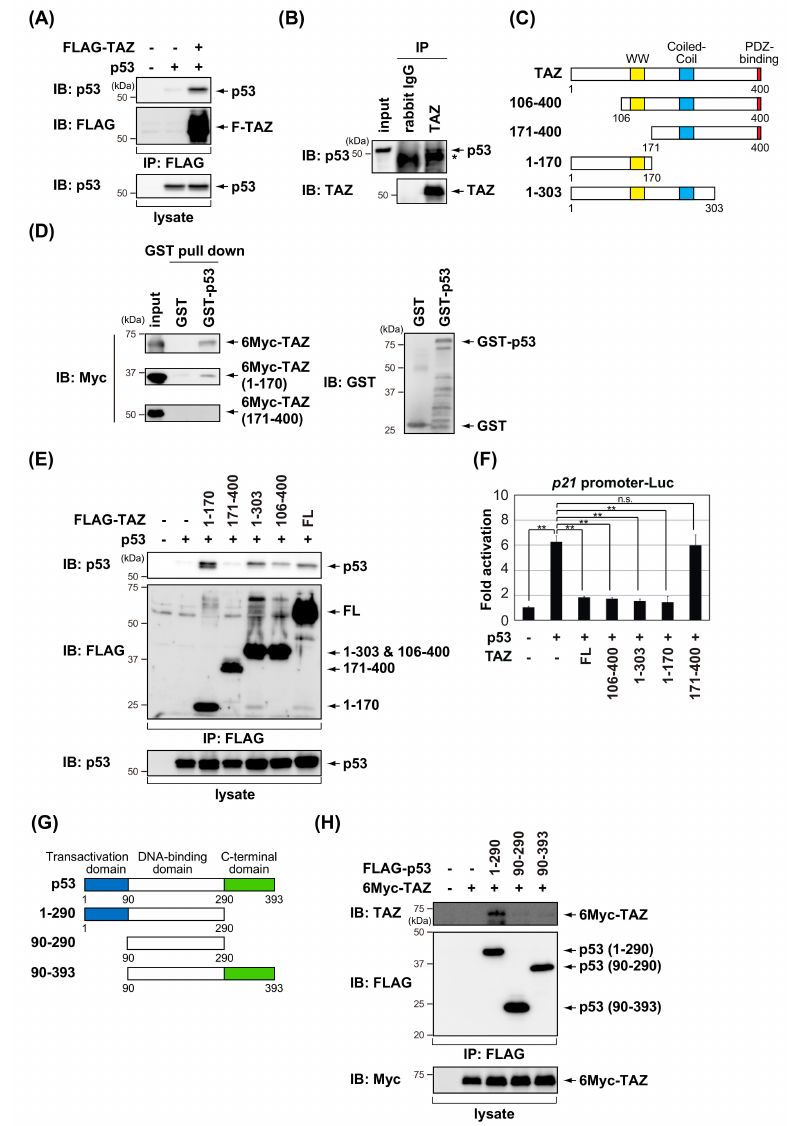
Figure 3. TAZ interacts with p53. ( A ) H1299 cells were transiently transfected with the indicated constructs. After 24 h, cell lysates were immunoprecipitated (IP) with an anti-FLAG antibody and then immunoblotted with the indicated antibodies. ( B ) MCF7 cells were treated with 10 µ M MG132, a proteasome inhibitor, for 8 h. Cell lysates were immunoprecipitated with an anti-TAZ antibody and then immunoblotted with the indicated antibodies. The asterisk indicates heavy chain of immunoglobulin. ( C ) Schematic representation of full-length TAZ and its deletion mutants. ( D ) In vitro interaction of GST–p53 with TAZ. Twenty-four hours before harvesting, H1299 cells were transfected with 6Myc-TAZ or its deletion mutants. Cell lysates were subjected to GST pull down and then immunoblotted with the indicated antibodies. ( E ) H1299 cells were transfected with the indicated constructs. After 24 h, cell lysates were immunoprecipitated (IP) with the anti-FLAG antibody and then immunoblotted with the indicated antibodies. ( F ) H1299 cells were transfected with p21 promoter-Luc and pCMV / β -gal in combination with the indicated constructs. After 24 h, luciferase activity in cell lysates was measured and normalized with β -gal activity. Experiments were performed in triplicate, and data are represented as mean activation fold ± S.D. ( G ) Schematic representation of full-length p53 and its deletion mutants. ( H ) H1299 cells were transfected with the indicated constructs. After 24 h, cell lysates were immunoprecipitated (IP) with the anti-FLAG antibody and then immunoblotted with the indicated antibodies. Significant di ff erences are indicated as ** p < 0.01. n.s.: not